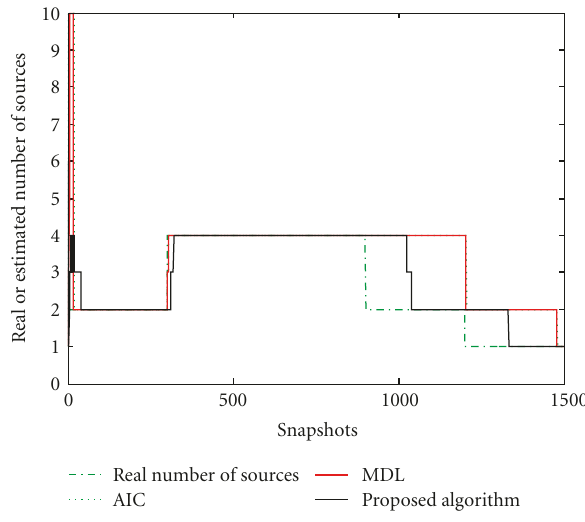
Figure 12: Real and Estimated number of sources versus number of snapshots.